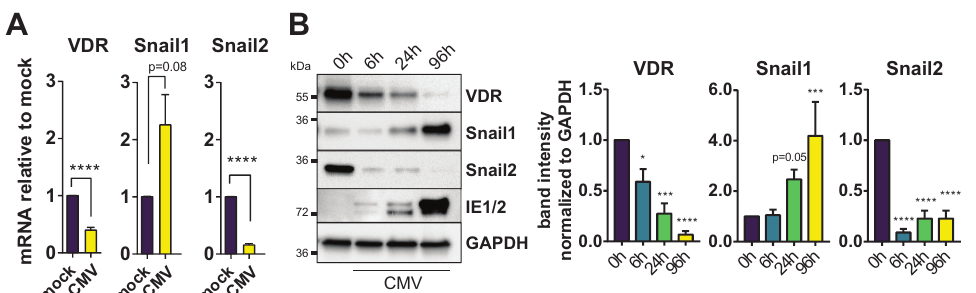
Figure 2. HCMV regulates the VDR repressors Snail1 and Snail2. ( A ) RT-qPCR analysis of VDR, Snail1 and Snail2 mRNA expression in mock- and CMV-infected HFF is shown. Asterisks indicate significant differences to the mock control sample (unpaired Student’s t test). ( B ) Immunoblots showing VDR, Snail1, Snail2 and IE1/2 expression compared to GAPDH loading control in HFF infected with CMV and harvested at the indicated time point p.i. Representative blot and quantification from multiple experiments with significant differences to the mock (0 h) control sample as determined by ANOVA Dunnett’s multiple comparison post-hoc